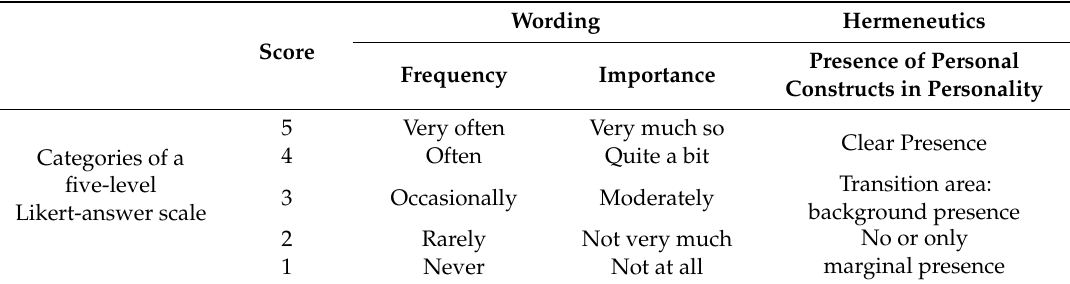
Table 1. Answer categories of CRS and their